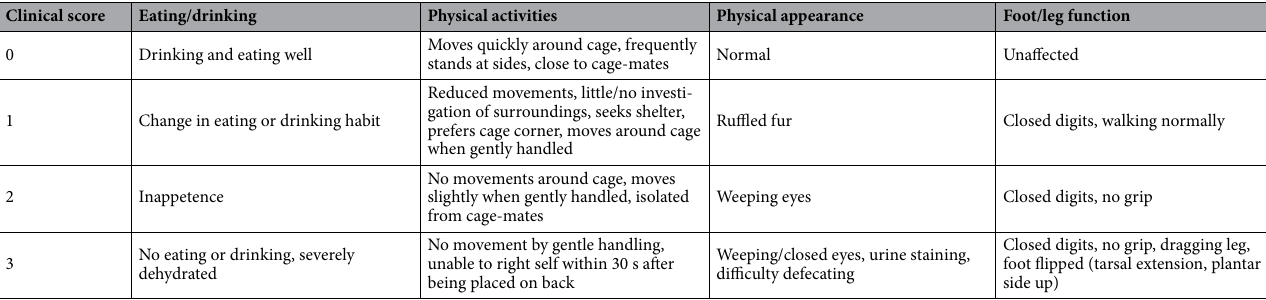
Table 2. Scoring systems for eating/drinking, physical activities, physical appearance, and foot/leg function/